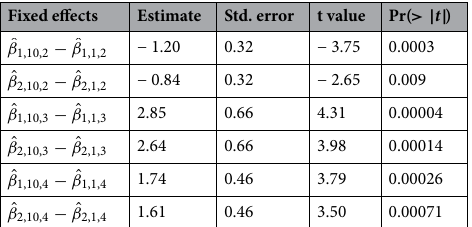
Table 2. The seven significant differences between fitted B-spline coefficients for MOA group 1 and